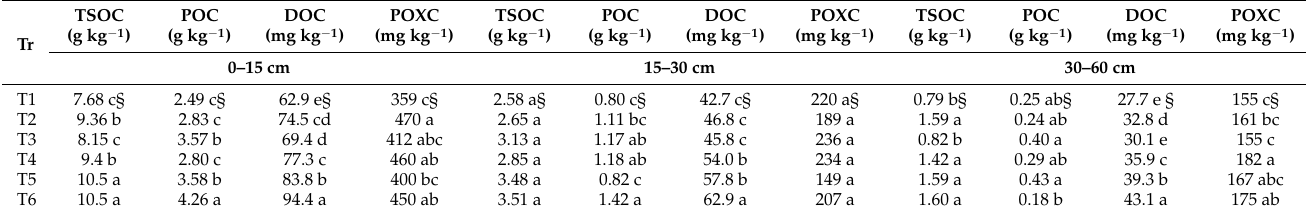
Table 4. Effect of organic manures and biofertilizers on total soil C (TSOC), particulate organic C (POC), dissolved organic C (DOC) and KMnO 4 oxidizable C (POXC) at 0–15, 15–30 and 30–60 cm soil depth under rice–wheat cropping